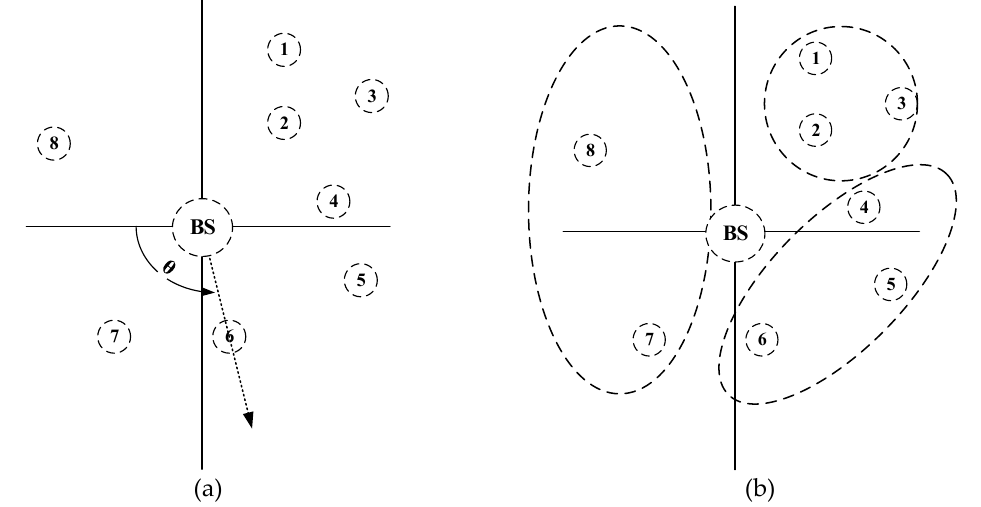
Figure 3. A scenario depicting how the clustering process in Algorithm 2 works. ( a ) Calculation of the angle of the ray originating from BS to the sensors. ( b ) Grouping and assigning sensors to be charged to mobile chargers.